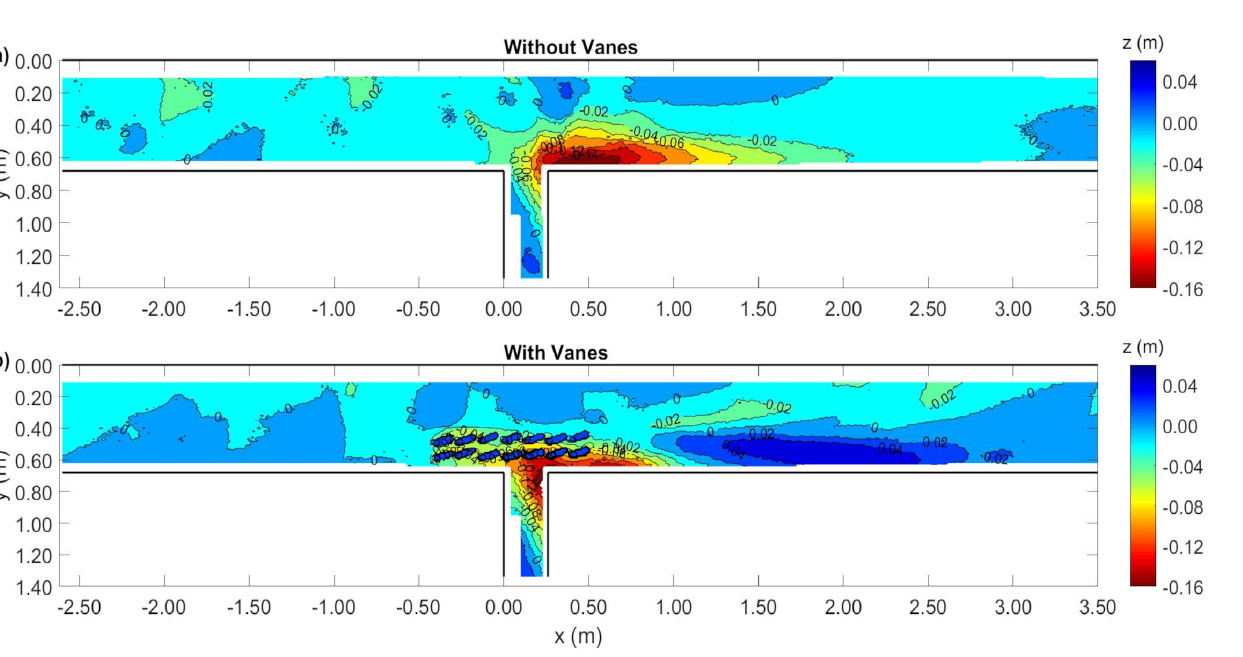
Figure 6. Bed-topography at equilibrium represented by contour lines: ( a ) in the NV experiment ( t = 12 h). ( b ) in the VF experiment ( t = 13:30